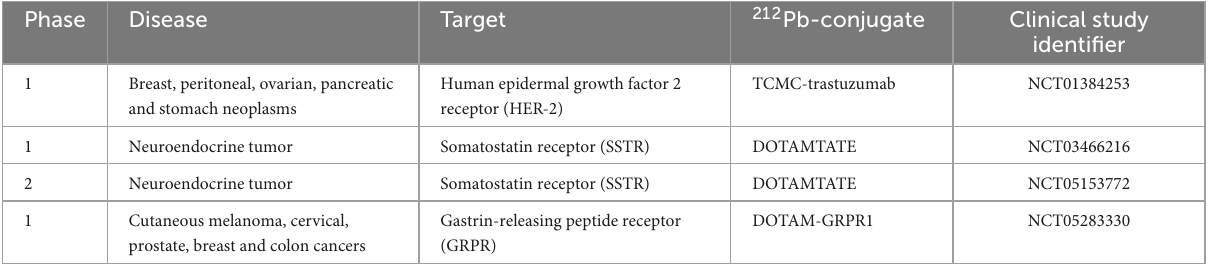
TABLE 4 List of clinical trials with 212